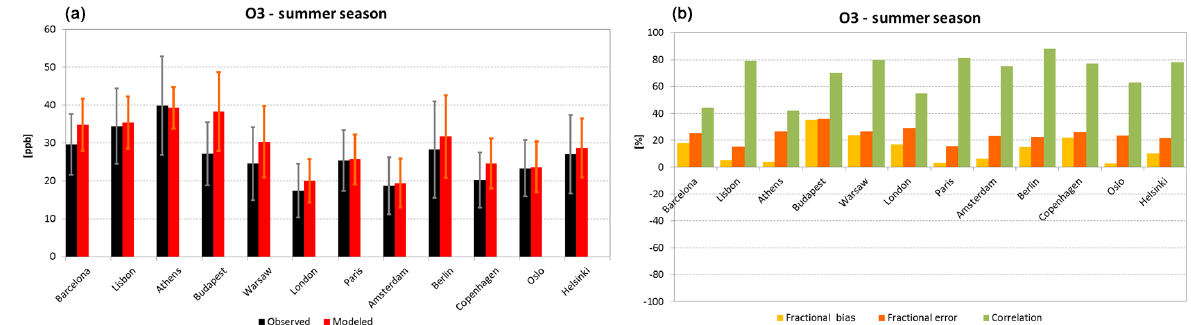
Figure 2. Evaluation of CAMx model performance for O 3 at selected cities for 1 July to 30 September 2010. (a) Comparison of the observed (black) and modeled (red) seasonal mean concentrations. Bars show the corresponding observed (grey) and modeled (orange) standard deviations. (b) The seasonal fractional bias (orange), fractional error (red), and correlation (green) computed for each city.